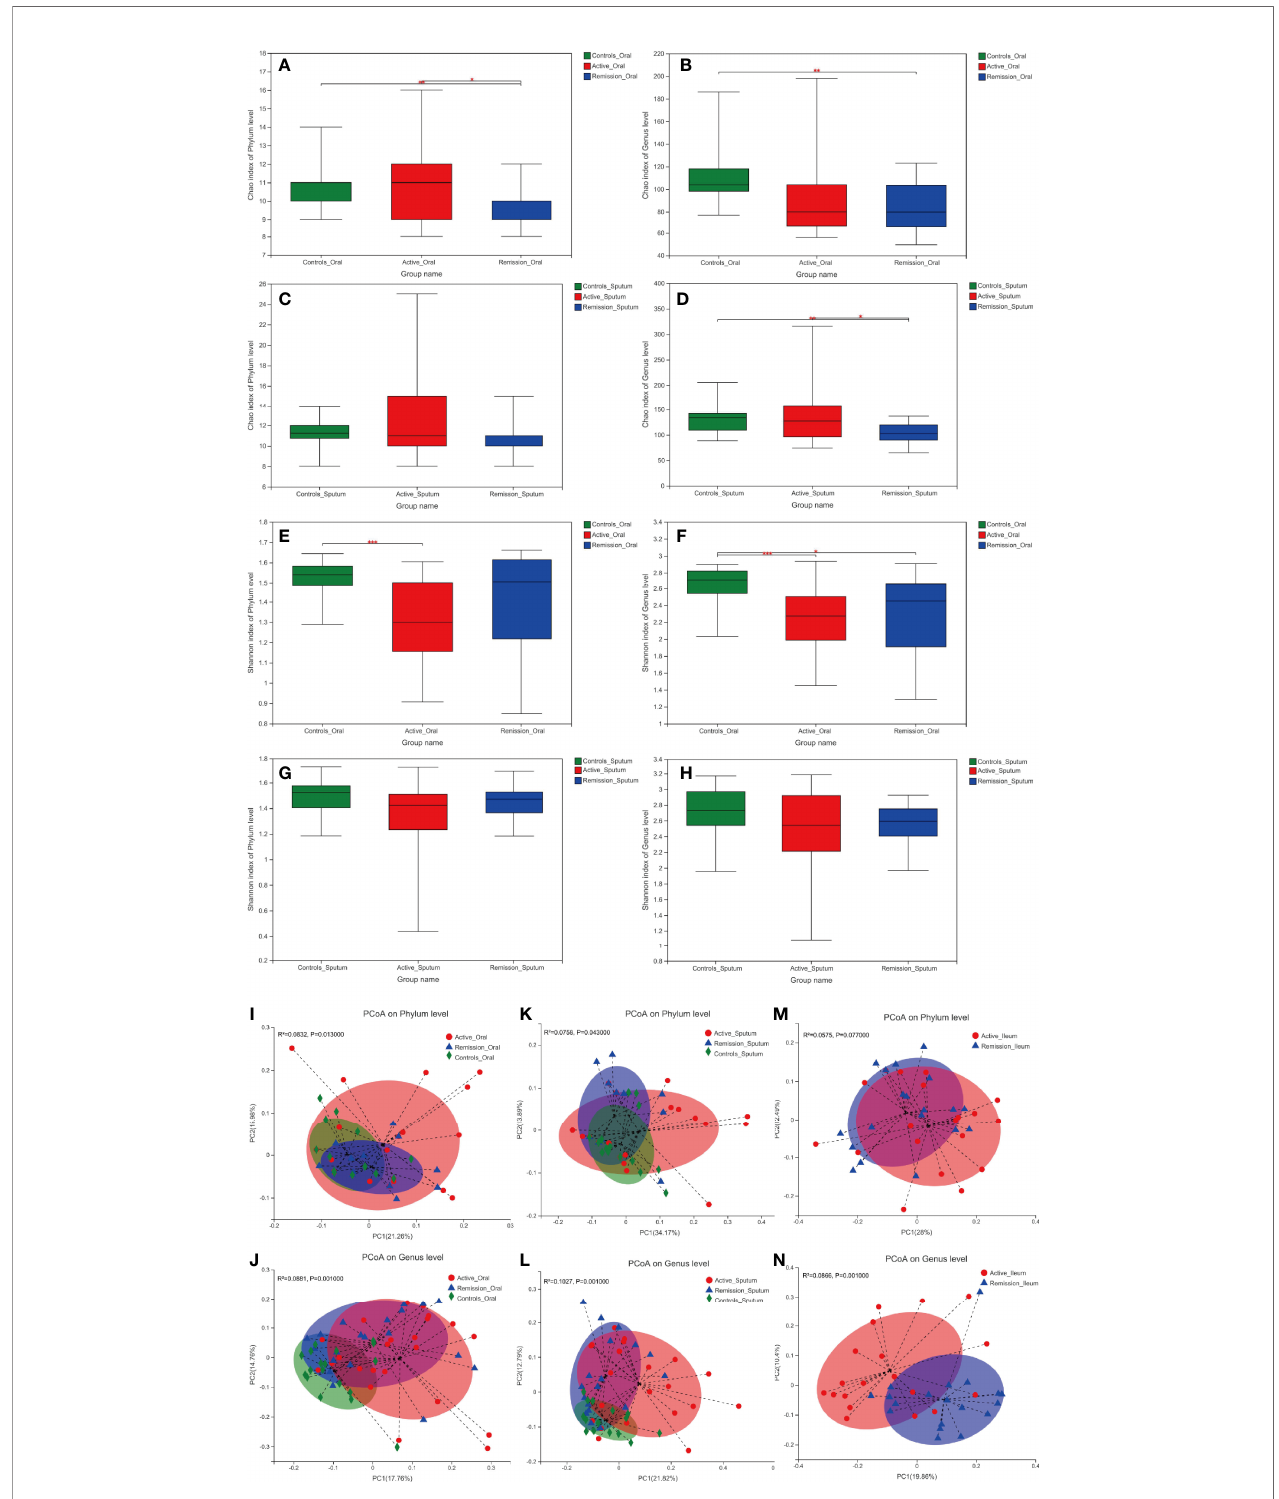
FIGURE 2 | Alpha and beta diversity of microbiota in the oral cavity and sputum of patients with CD and healthy controls. (A – D) Chao diversity index of phylum and genus levels in the samples of oral cavity and sputum. (E – H) Shannon diversity index of phylum and genus levels in the samples of oral cavity and sputum. (I – N) Principle coordinate analysis (PCoA) on the phylum and genus levels using the unweighted UniFrac distance and Adonis test. Red color represents samples from active stage, blue indicates remission stage, while green color indicates healthy controls. *, **, and *** correspond to p-values <0.05, 0.01, and 0.001,